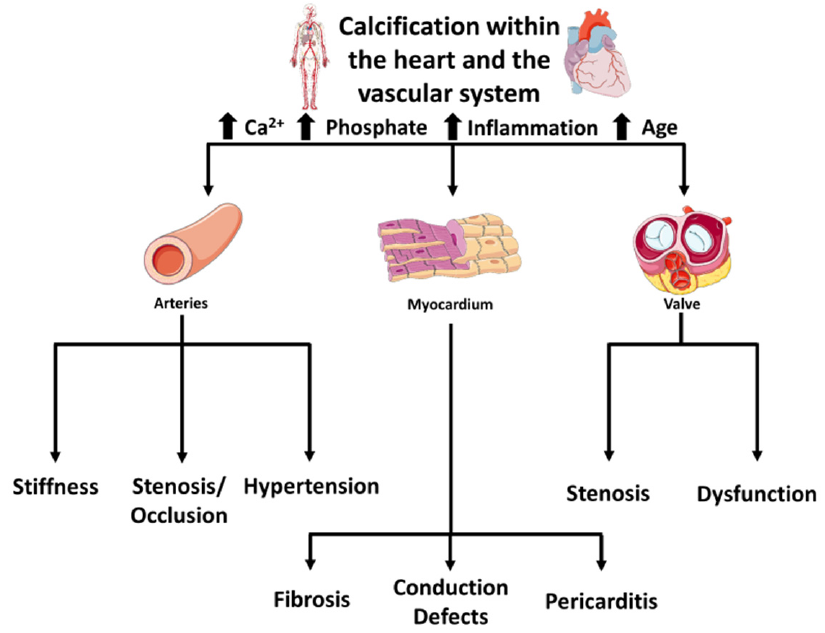
Figure 1. Pathological calcifications and clinical consequences that can occur within the heart and the vascular system.